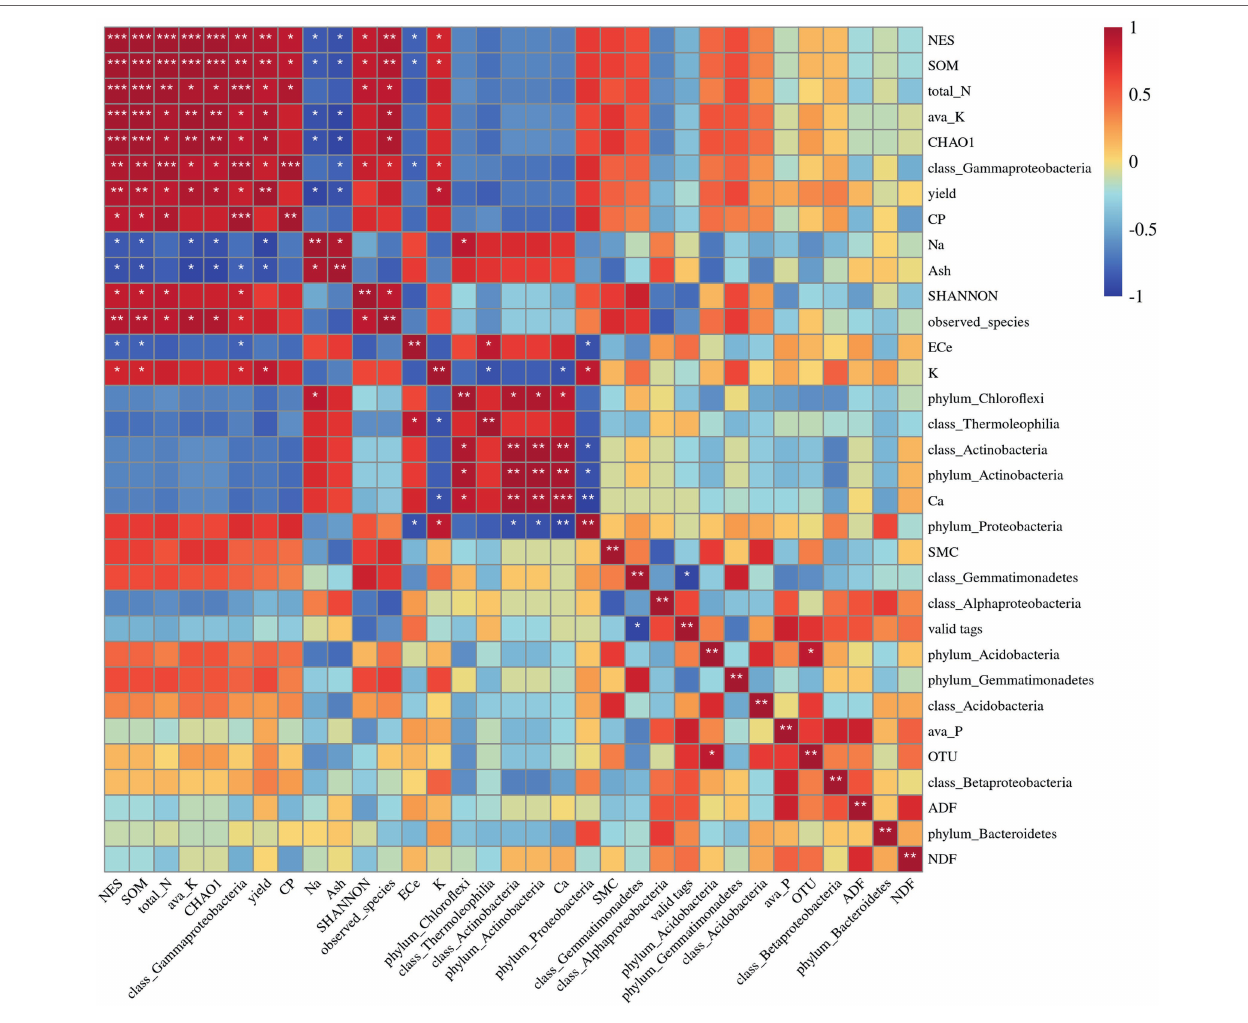
FIGURE 9 | Spearman correlation analysis among soil and plant properties and soil fungal abundance, diversity, and relative abundance of dominant bacteria phyla and classes. NES, number of emergence seedling; SMC, soil moisture content; ava_K, available K; ava_P, available P. The values presented by colors in the heat map correspond to the Spearman correlation coefficient r, which ranged between − 1 and 1, where r < 0 indicates a negative correlation (blue), r > 0 indicates a positive correlation (red), “*” represents p < 0.05, “**” represents p < 0.01, “***” represents p <